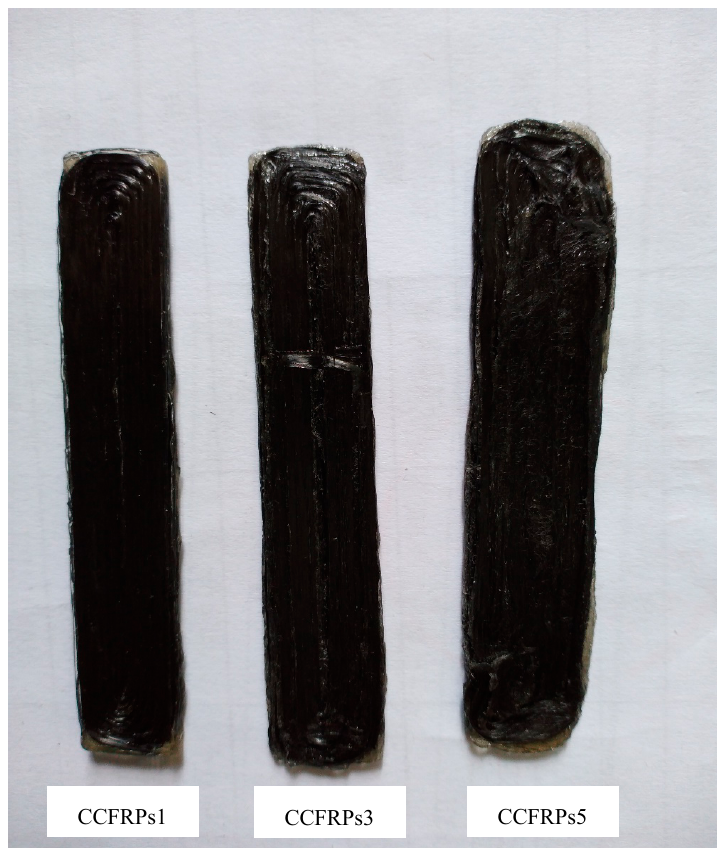
Figure 11. The models printed by CCFRPs1, CCFRPs3 and CCFRPs5.